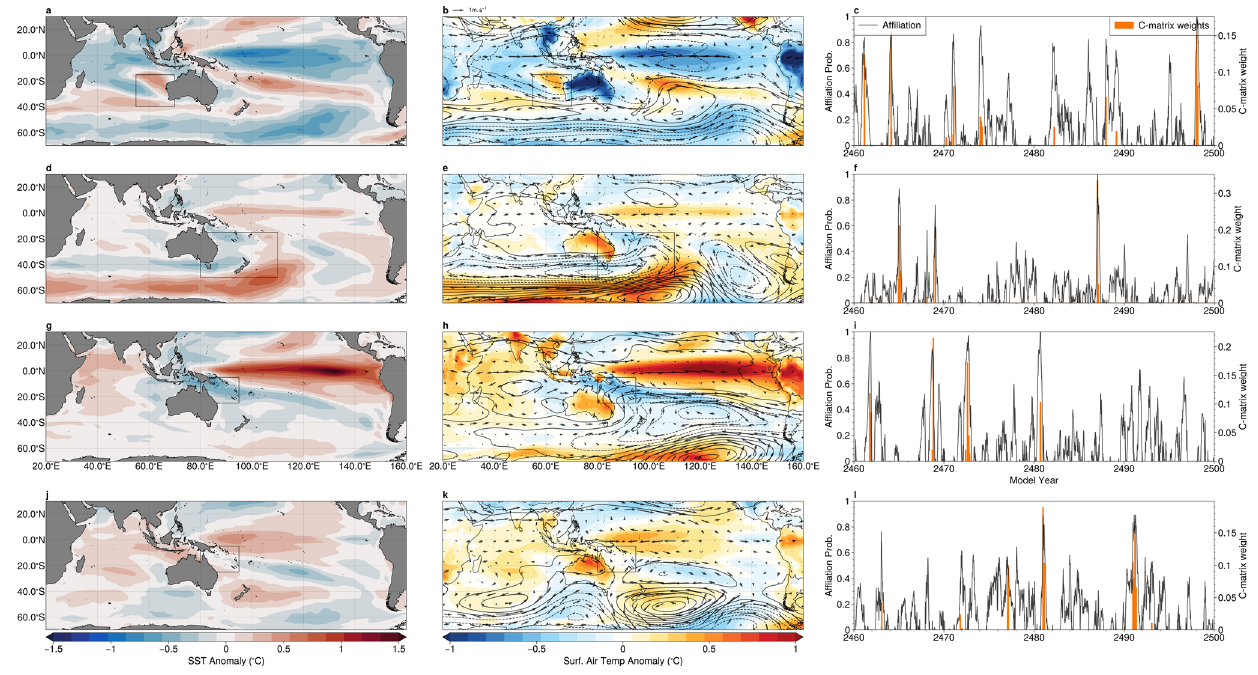
Fig. 10 | Broad-scale patterns associated with marine extremes in a climate model. a , d , g , j : anomalous sea-surface temperature; b , e , h , k : surface air tem- perature (colours), mid-tropospheric (500hPa) atmospheric geopotential height anomaly(contourlines,contourinterval5m),andwind(vectors). c , f , i , l :af fi liation